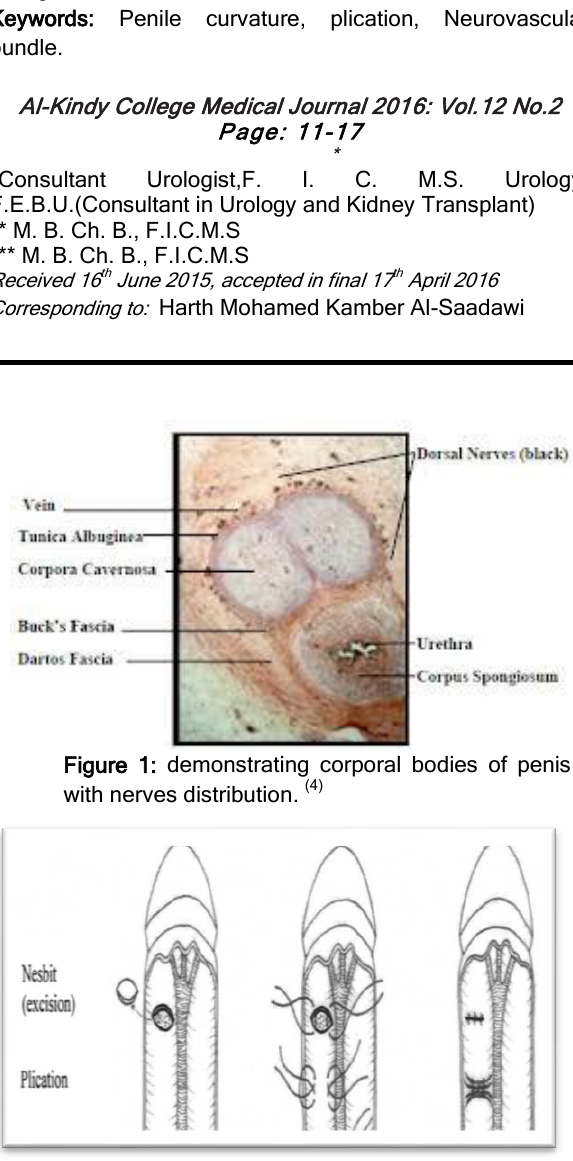
Figure 2: Schematic illustration of different surgical procedures on dorsal part of penis